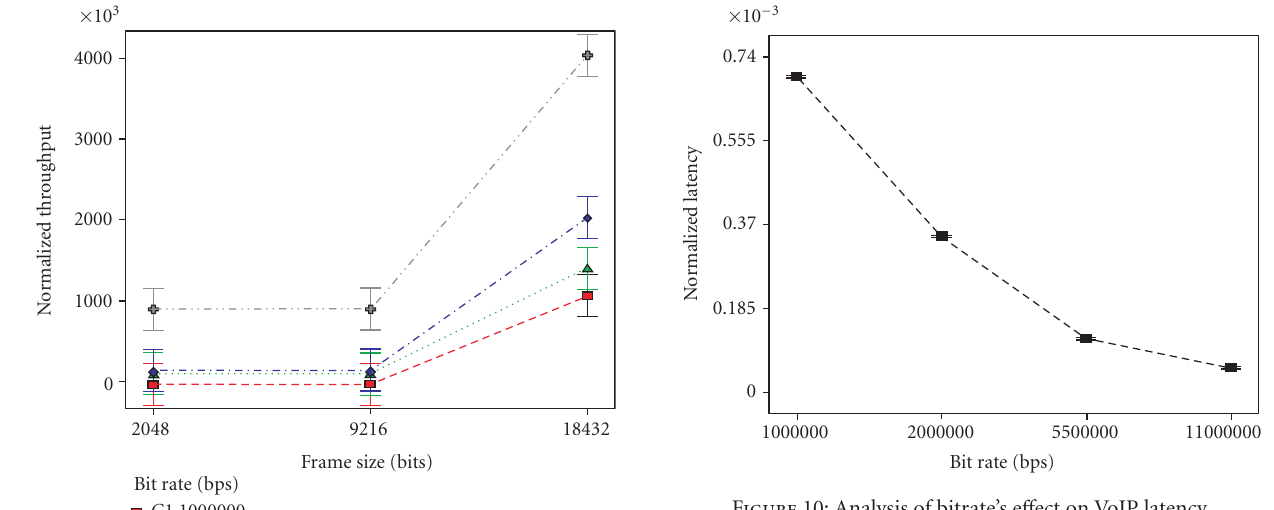
Figure 10: Analysis of bitrate’s e ff ect on VoIP